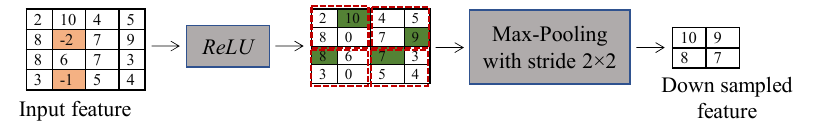
Figure 8. Conceptual explanation of ReLU and max-pooling.